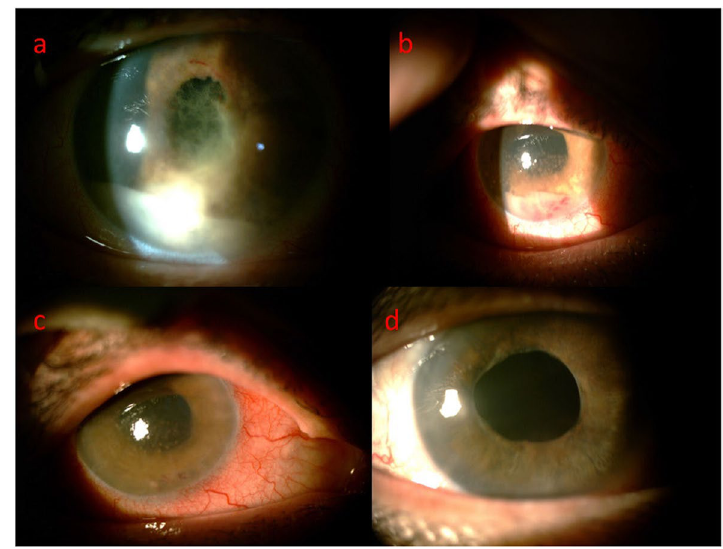
Fig. 1 Slit photography of the right eye; hypopyon anterior uveitis with severe fibrinous reaction following 2 months therapy as a uveitis case ( a ), Following third ocular sampling and cataract surgery ( b ), two weeks following intraocular methotrexate injection ( c ), One year after the first presentation ( d